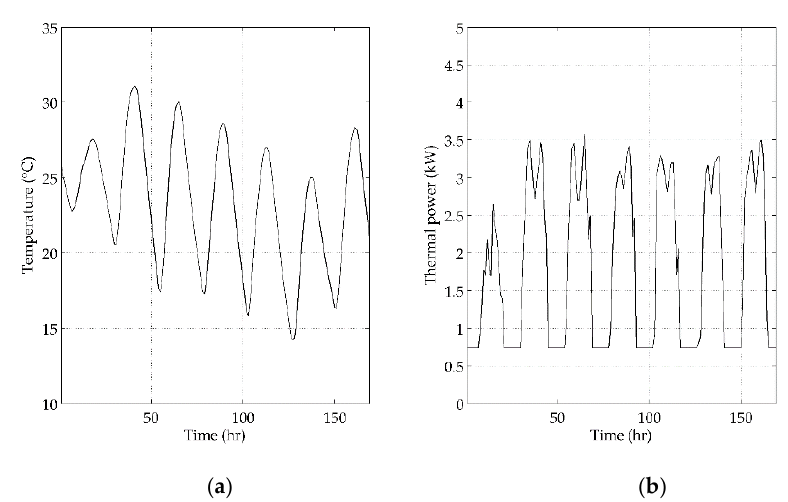
Figure 5. MPC uncontrollable inputs (disturbances) for the selected summer week: ( a ) ambient temperature, T amb ; ( b ) total gains, G .